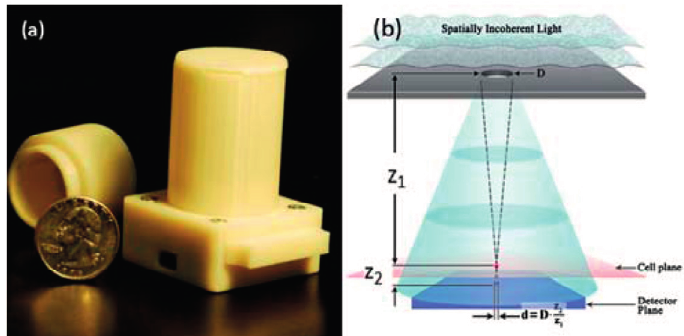
Figure 11. ( a ) A lensless on-chip microscope based on holography powered by USB connection which utilized LED sources and CMOS sensor array. ( b ) Schematics of the microscopy. The size of the hole is 50 to 100 μ m and it is 3 to 4 cm above the sample. This allowed to cover FOV of ~24 mm 2 (Reproduced with permission from